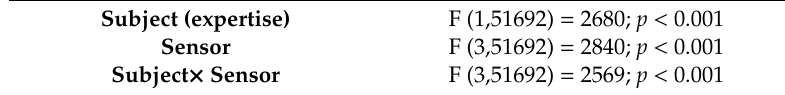
Table 3. F-statistics from the two-way analysis of variance for e ff ects of expertise and sensor.